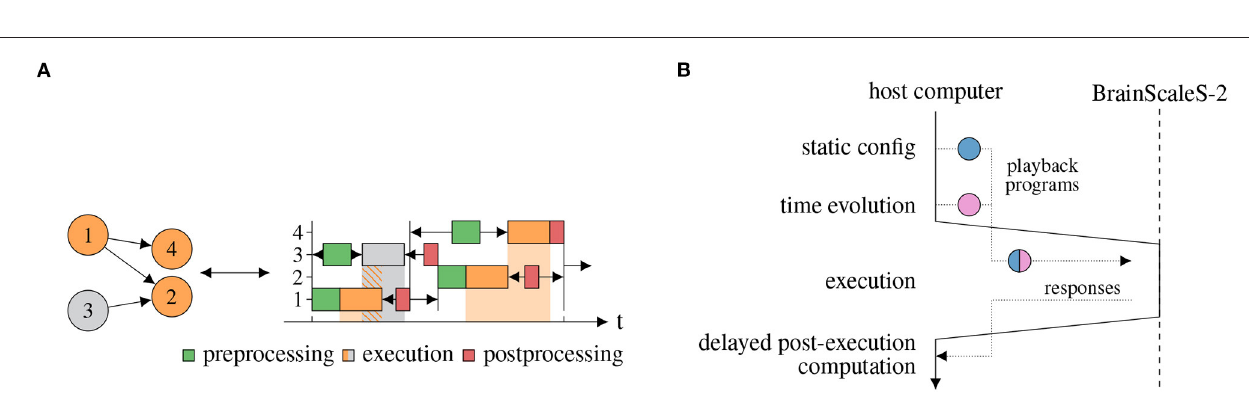
FIGURE 5 | JIT compilation and execution of signal-flow graph of multiple execution instances and within a single execution instance. (A) JIT execution of a graph on two physical chips, adapted from Spilger et al. (2020). Left: Execution instance 3 is to be executed on another physical chip than the other execution instances. Right: The execution of instance 3, depicted in gray, can be performed concurrently to execution instance 1. (B) JIT compilation and execution of a single execution instance subgraph. First, the static configuration is extracted by a vertex visit and transformed to hardware configuration where applicable. Then, the real-time execution is built by a vertex visit. This built program is executed on the neuromorphic hardware and results are transmitted back to the host computer. Finally, delayed digital operations, which require output data from the execution, are performed on the host